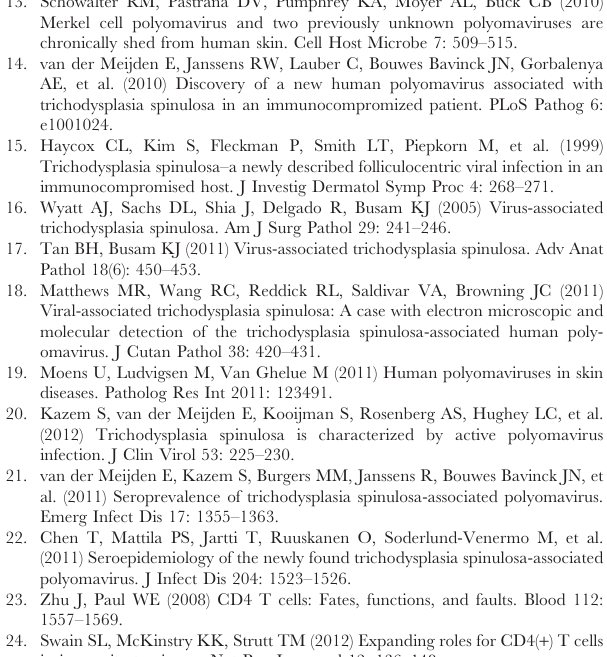
Table S2 Comparison of IFN- c and IL-10 responses against MCV VP1 and Candida albicans among MCV + TSV 2 and MCV – TSV + groups. (PPT) Table S3 Comparison of VP1 amino acid sequence of MCV and TSV with other polyomaviruses. (PPT) Note S1 MCV and TSV-specific Th-cell responses and clinical information about MCC patient.